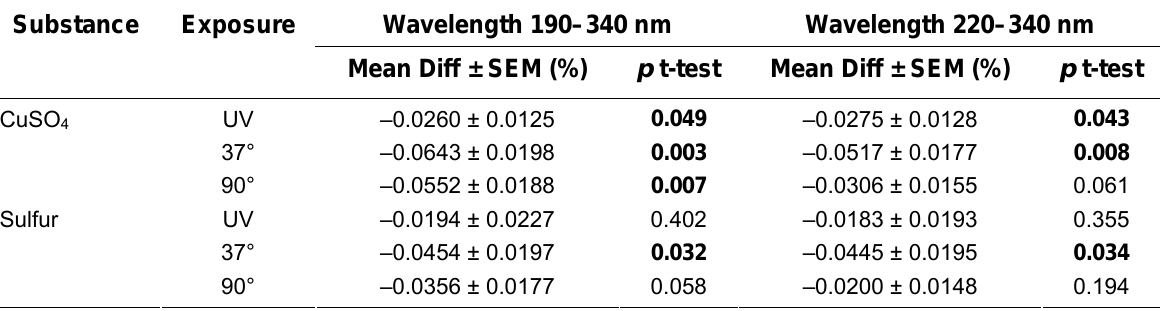
Statistical Comparison between Unexposed and Exposed Homeopathic Preparations (without